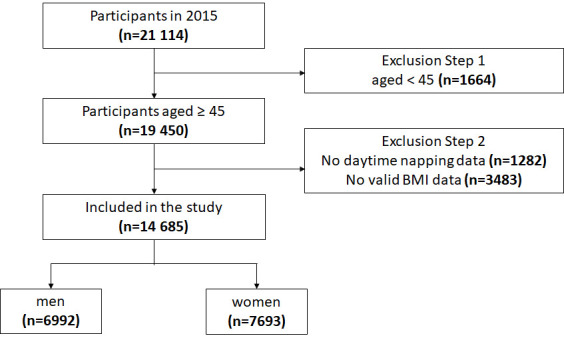
Sample included in the study.